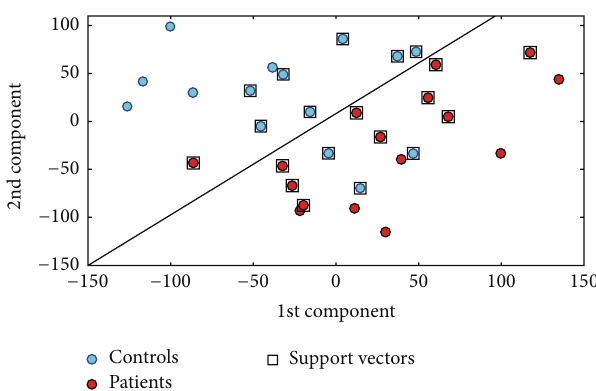
Figure 2: Decision function for the ED versus HC group discrim- ination (1st and 2nd components with highest FDR). Data from a single round of CV are shown as a representative example.